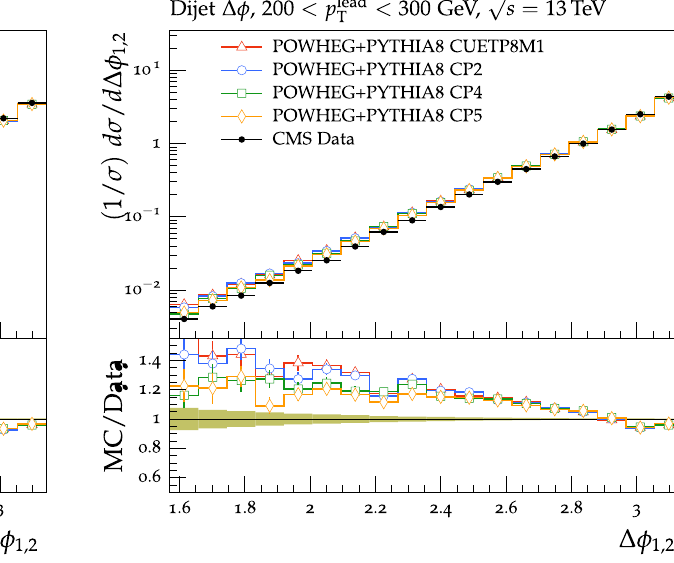
Fig. 17 The azimuthal difference Δφ 1 , 2 between the leading two jets in the plot but present a similar behavior as tunes CP2 and CP4. The with | η | < 2 . 4 in dijet events with leading-jet transverse momentum ratios of simulations to the data (MC/Data) are also shown, where the < 300GeV and (right) 300 < p lead < in the range (left) 200 < p lead shaded band indicates the total experimental uncertainty in the data. √ T T s = 13TeV analysis [57]. The jets are recon- 400GeV, from the CMS Vertical lines drawn on the data points refer to the total uncertainty in structed using the anti- k T jet finding algorithm [58,59] with a distance the data. Vertical lines drawn on the MC points refer to the statistical uncertainty in the predictions. Horizontal bars indicate the associated parameter of 0.4. The data are compared with predictions of the NLO bin width dijet ME calculation from powheg , interfaced to the pythia 8 tunes CUETP8M1, CP2, CP4, and CP5. Tunes CP1 and CP3 are not shown